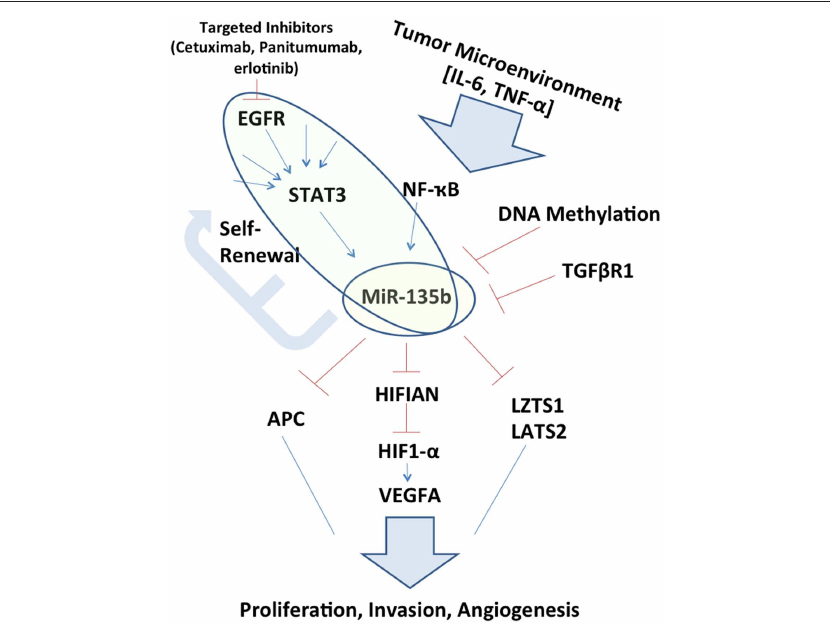
FiGuRE 1 | Schematic representation of miR-135b circuitry network. Studying the network surrounding miR-135b may elucidate links between otherwise far reaching pathways, such as EGFR/STAT3 signaling to Hippo (LZTS1, LATS2) and inhibition of growth. miR-135b silencing in vivo may itself be therapeutic and understanding its function may uncover additional therapeutic